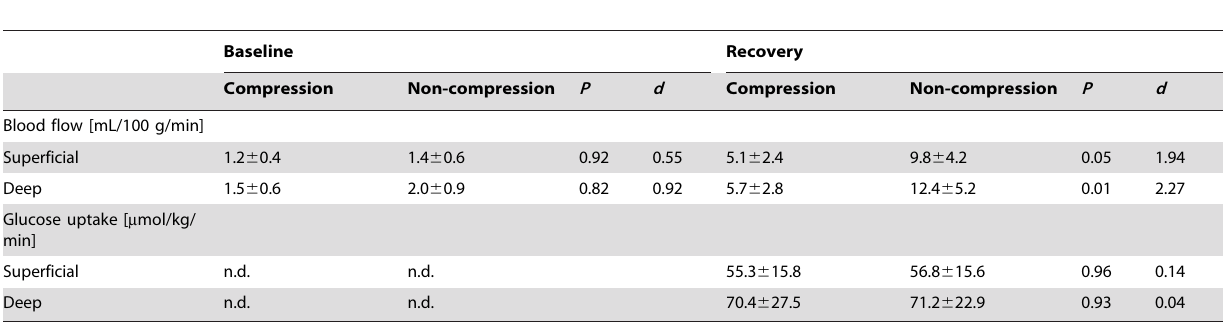
Table 3. Skeletal muscle blood flow and glucose uptake in superficial and deep parts of m. quadriceps femoris (n.d. =not